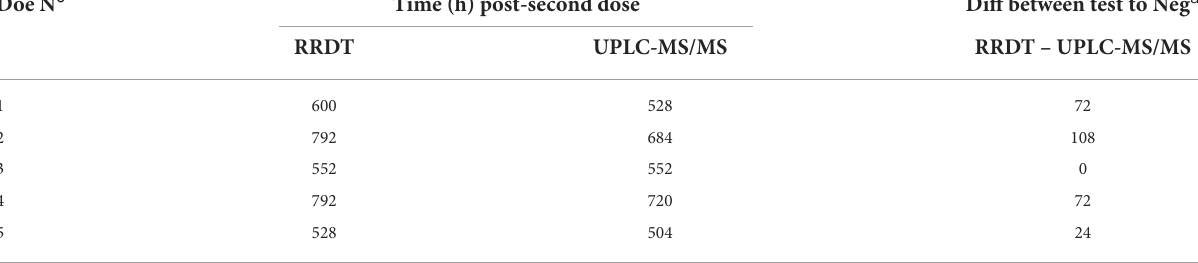
TABLE 4 Sampling time point after second florfenicol treatment when florfenicol concentrations in milk samples were below the limit of detection (LOD, 3 ppb) on ultra-performance liquid chromatography with tandem mass spectrometry (UPLC-MS/MS), and after the third consecutive negative test result using the rapid residue detection test (RRDT) strips in